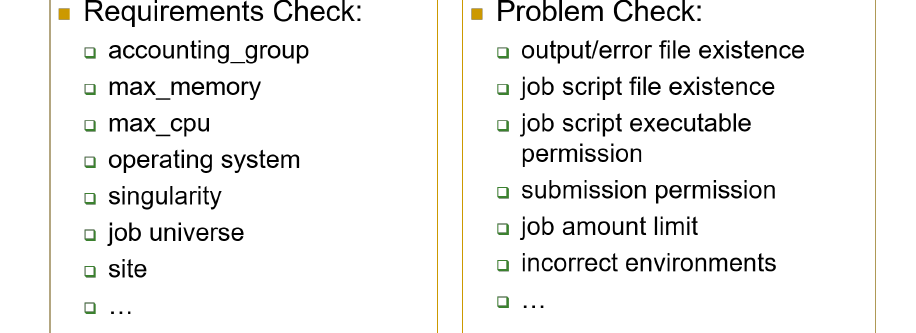
Figure 6: Pre-check Metrics